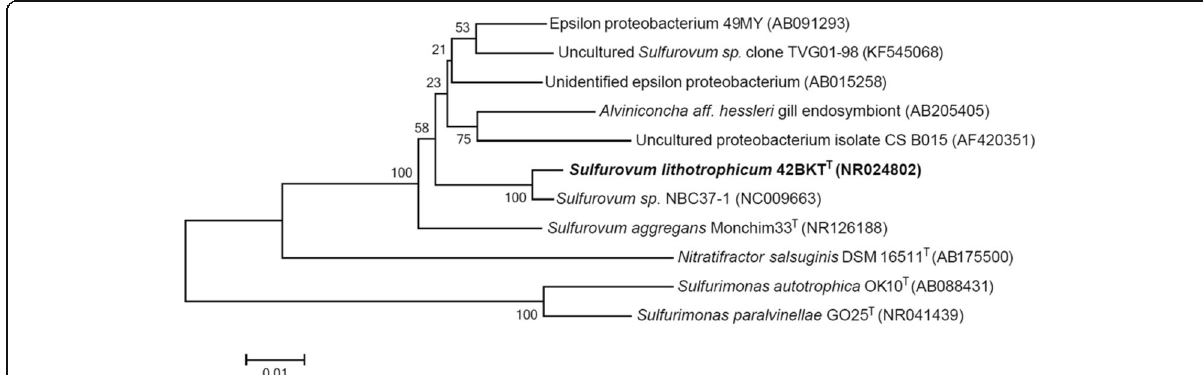
Fig. 1 Phylogenetic tree showing the relative position of Sulfurovum lithotrophicum 42BKT T , based 16S rRNA gene sequence. All sites were informative and free of gaps. Evolutionary history was inferred using the neighbor-joining method [35]. The tree was built using the maximum composite-likelihood method [36]. The percentage of replicate trees with the associated taxa clustered together in the bootstrap test (1000 replicates) is shown next to the corresponding branches [37]. Evolutionary analyses were conducted in MEGA6 [38]. Corresponding GenBank accession numbers are shown in brackets next to the strain name